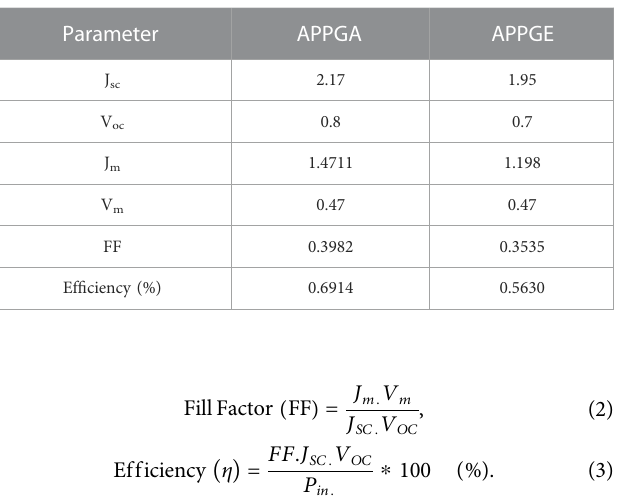
Figure 9 represents the JV characteristics of the APPG leaf extracts of acetone and ethanol. The JV properties of a solar cell using the APPG dye with solvent acetone (APPGA) and ethanol (APPGE) have a substantial impact on electron injection, charge transfer, and redox couple reduction. It was discovered that oxidation of the dye after photon energy absorption and regeneration of dye molecules by reduction occurred within a